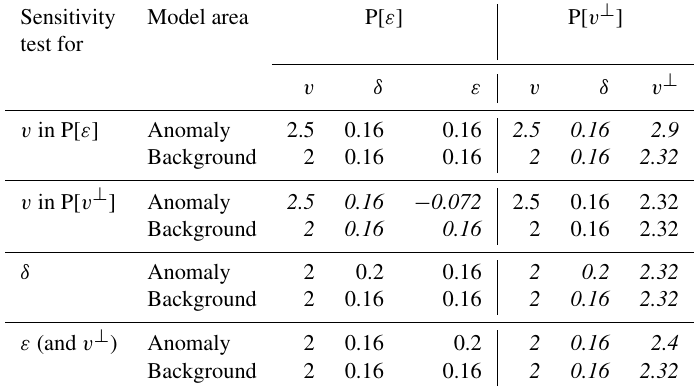
Table 1. Values for anomaly and background areas of the models used in each of the four sensitivity tests and their equivalence in the alternative parameterization (italic values) (Fig. 2). Accuracy tests in Fig. 3 are conducted for these same four cases. A comparison with the accuracies achieved using the alternative parameterizations can be seen in Fig. S2.